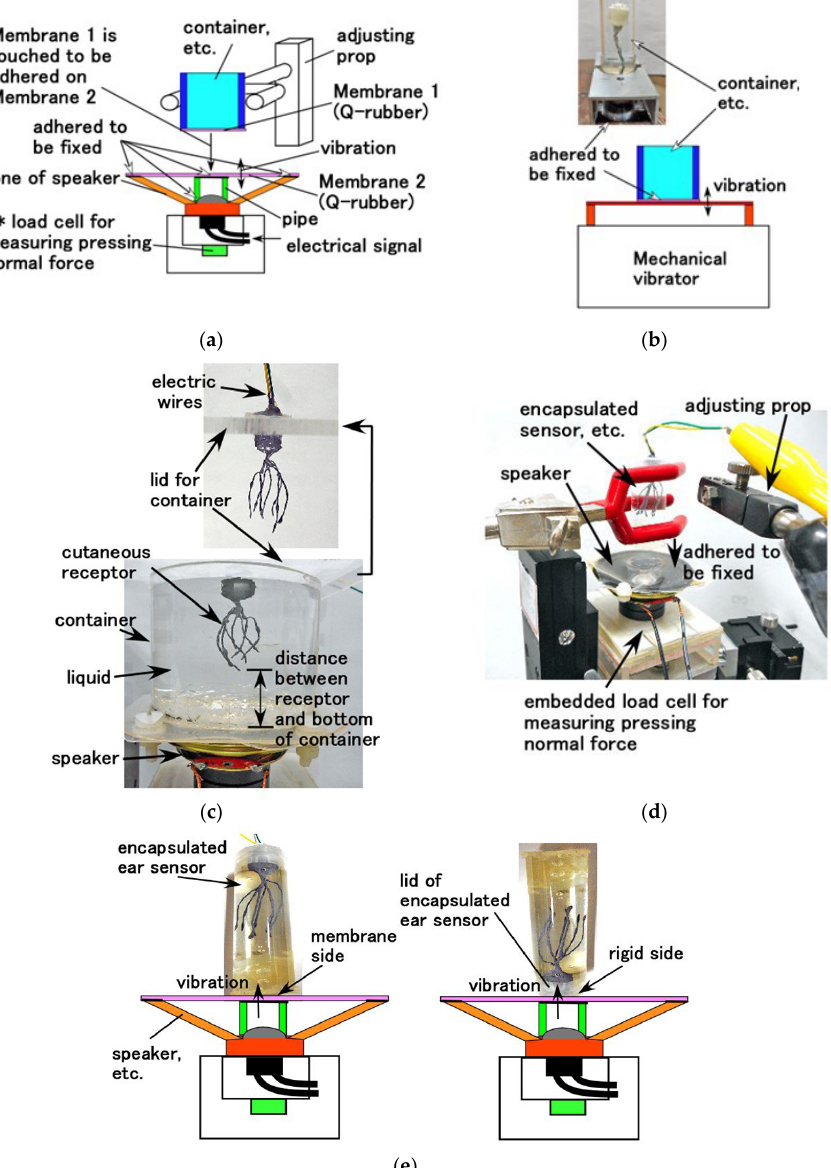
Figure 9. Schematic and images of the apparatus for the vibration and acoustic experiment; ( a ) vibration for a wide-ranged frequency and acoustic experiment by the speaker; ( b ) vibration by the mechanical vibrator for low frequency; ( c ) posture of the receptor in the container of the apparatus with a speaker; ( d ) posture of the sensor in the apparatus with a speaker; ( e ) posture of the auditory sensor mimicking organ of Corti in the apparatus with a